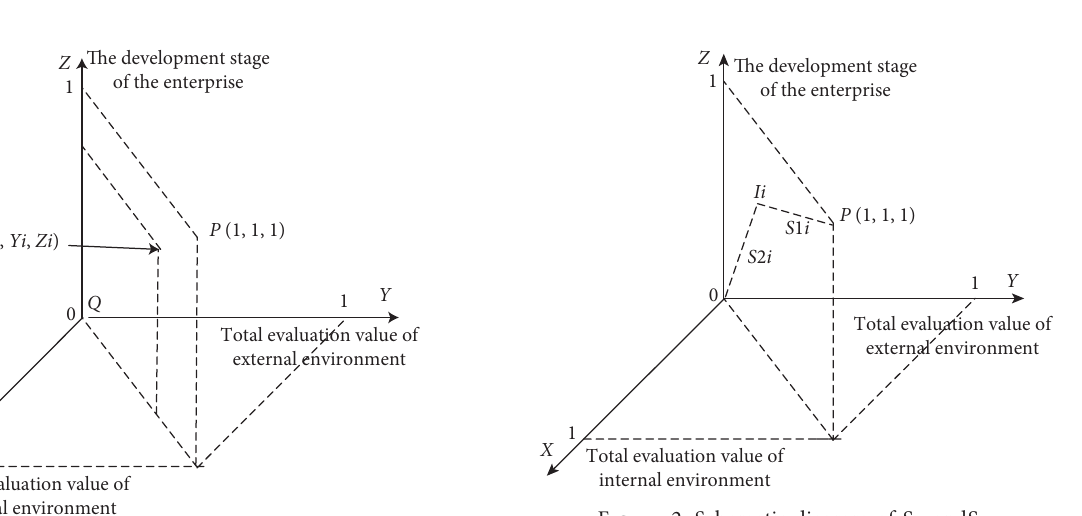
Figure 1: Path selection model of intelligent manufacturing promoted by manufacturing enterprises.